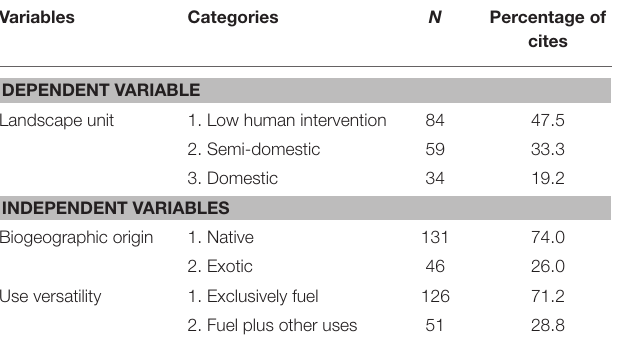
TABLE 2 | Summary of cases for variables of multinomial logistic model representing the firewood species gathered by the Mapuche communities of Costa del Lepá and Gualjaina.